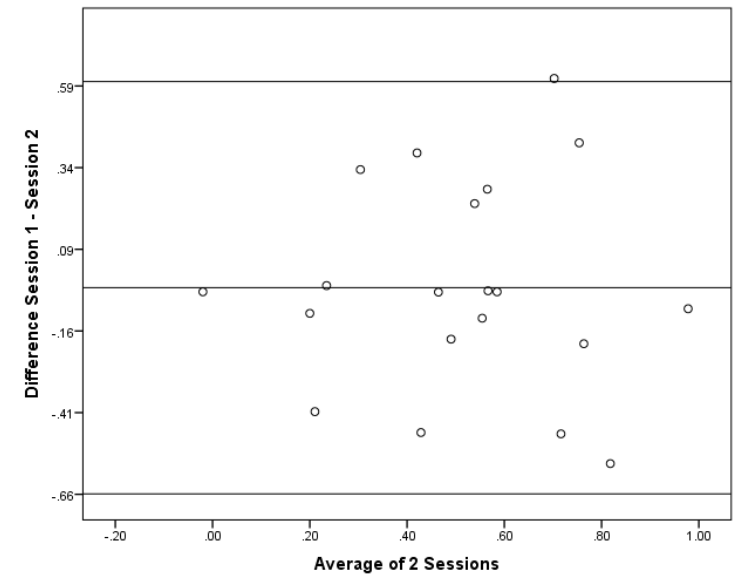
Figure 5. Bland–Altman Plot for the Subgroup 1 ( n =